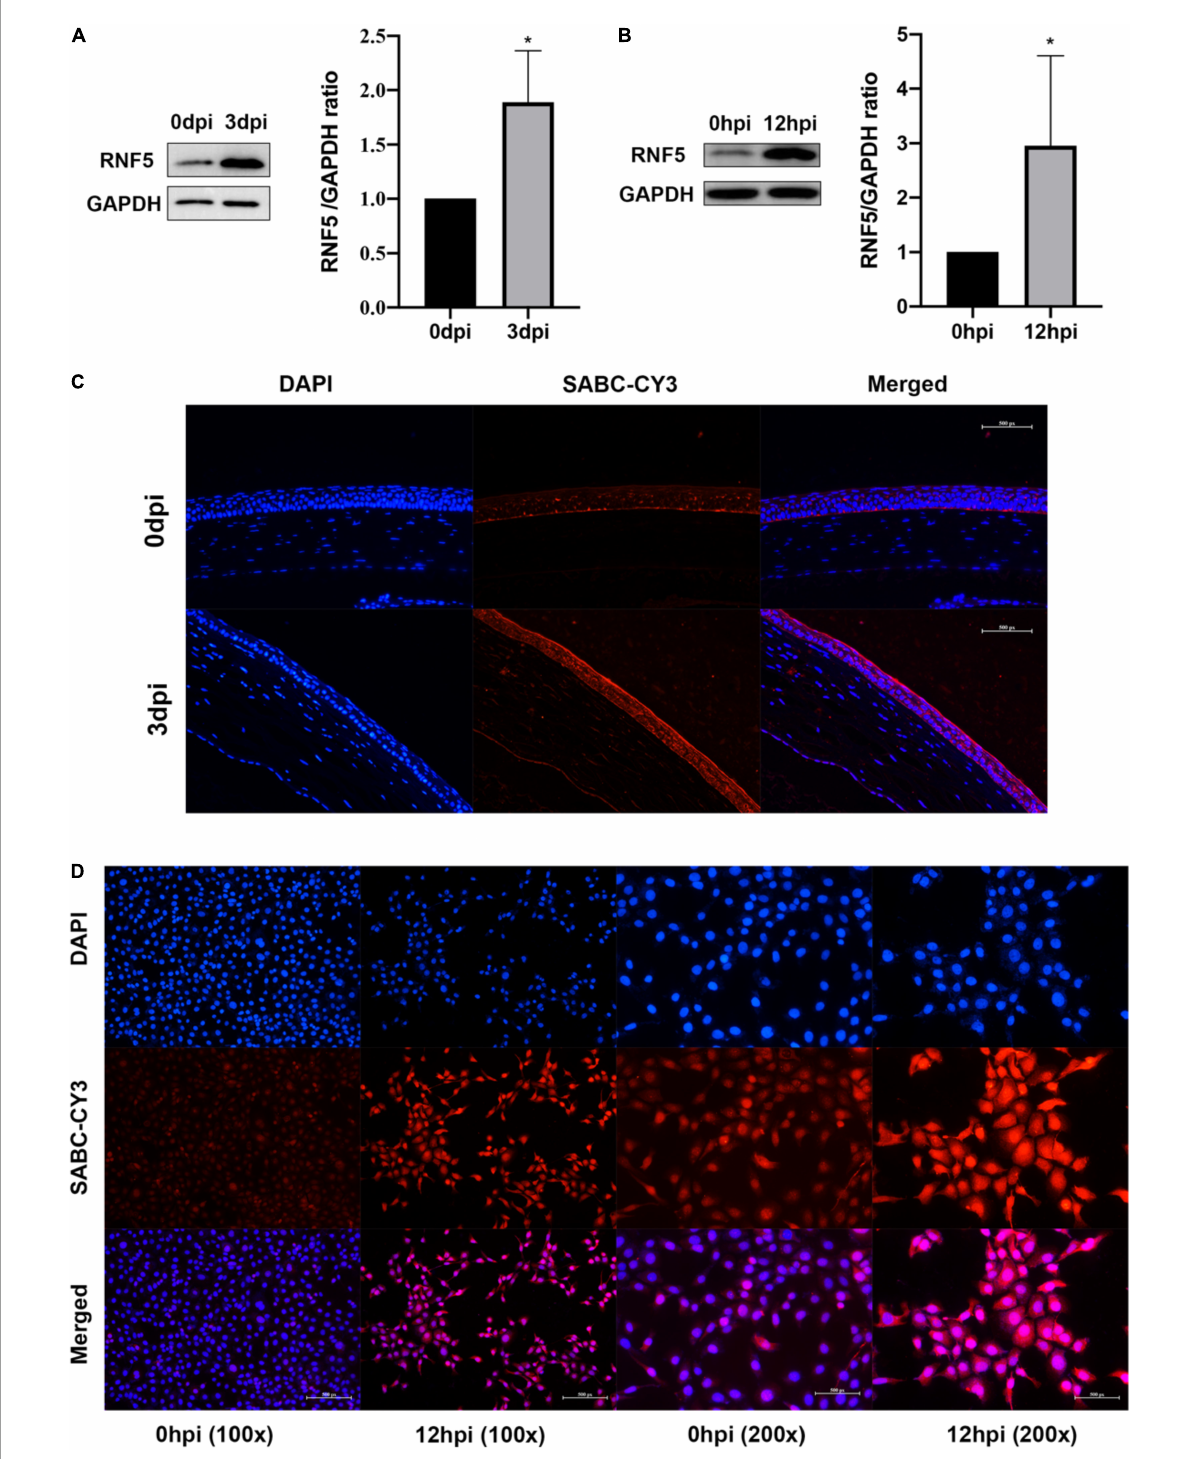
FIGURE1 RNF5 is highly expressed after HSV-1 infection. (A) The mouse cornea was inoculated with HSV-1 to establish an HSK model. The corneas were harvested for Western blot analysis on days 0 and 3 after the infection. Three corneas were tested in each group. The data are shown as the mean ± SD of three independent experiments. * P < 0.05. (B) Human corneal epithelial cells (HCECs) were inoculated with HSV-1 at a multiplicity of infection (MOI) of 10. At 12 h after the infection, the expression of RNF5 was detected using Western blotting (mean ± SD). * P < 0.05. (C) On days 0 and 3 after the infection, the expression of RNF5 in the cornea was assessed using immunofluorescence. The blue fluorescence indicates the nucleus, and the red fluorescence indicates RNF5 expression (magnification, 200 × ). (D) Immunofluorescence staining was performed 12 h after the HCECs were infected with HSV-1. The nucleus appears blue, and RNF5 expression appears red (magnification, 100 × and 200 ×